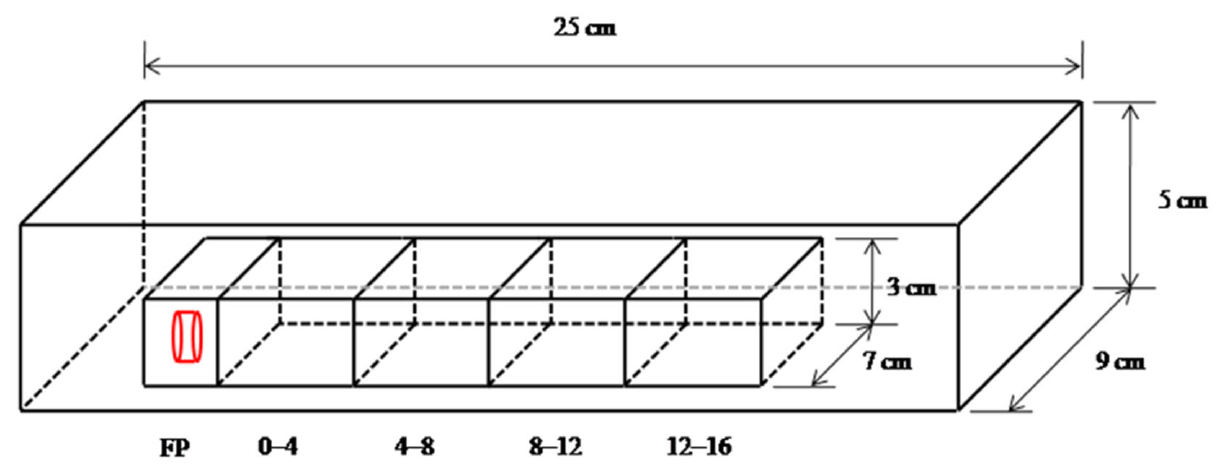
Figure 1. Schematic diagram of the soil-sampling process. The red cylinder is the fertilizer point.